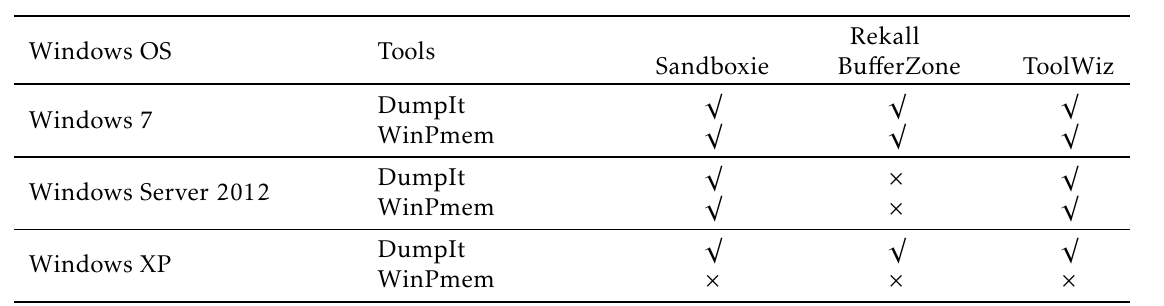
Table 8. Rekall analysis process status